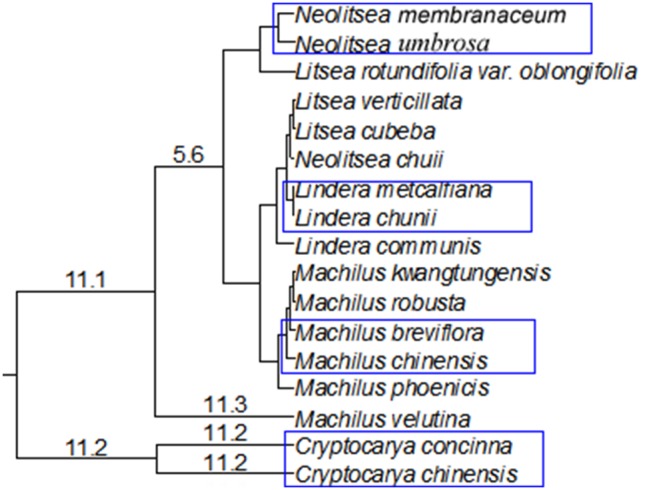
Genetic relationships of Lauraceae species.The numbers related clustering coefficient. The eight species enclosed within rectangles are the same species in Table 1.